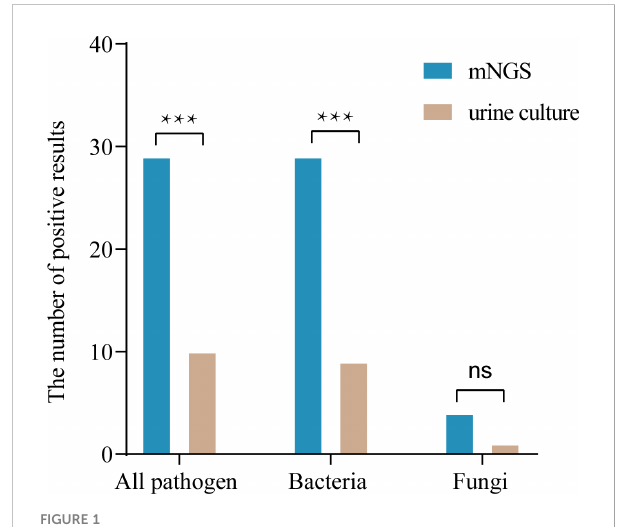
FIGURE 1 Comparison of diagnostic performance in pathogen detection between mNGS and culture (n=33). *** P < 0.001; ns, not signi fi cant.